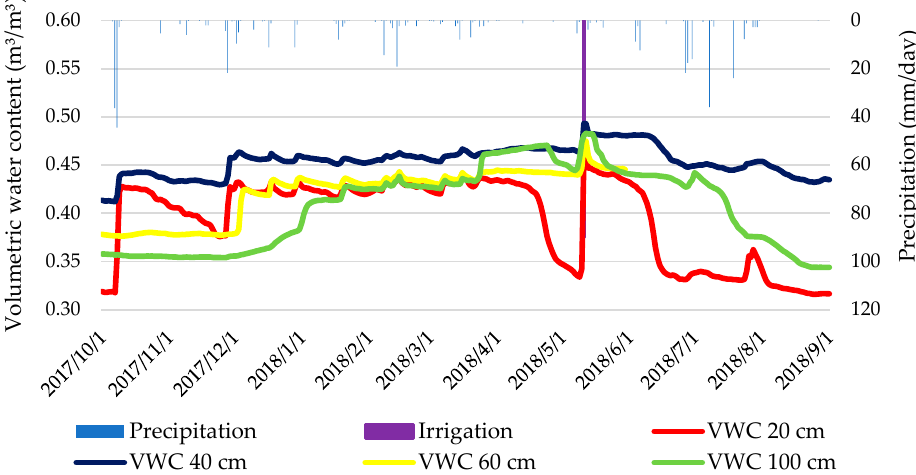
Figure 8. Precipitation, irrigation and soil moisture monitoring at different depths on soil profile, on irrigated sunflower field.